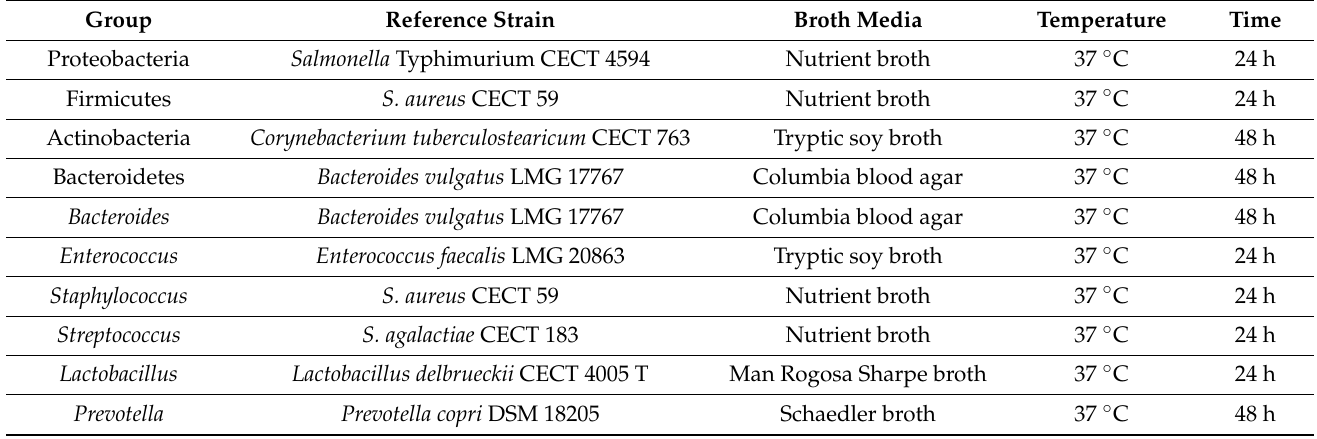
Table 2. List of bacteria used to build qPCR absolute curves and growth